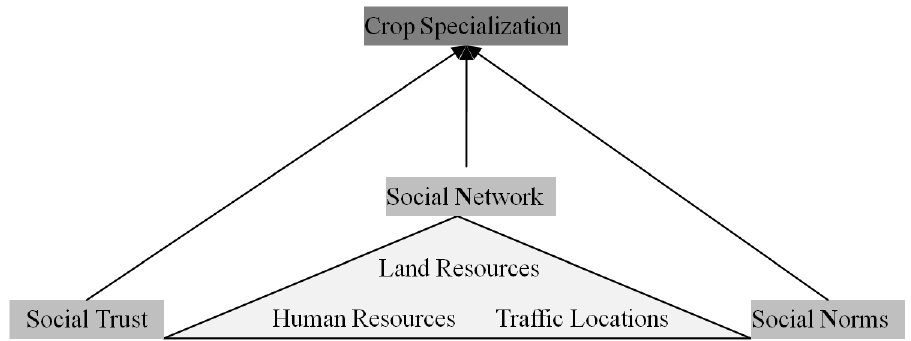
Figure 3. Village social capital and basic conditions for crop specialization.